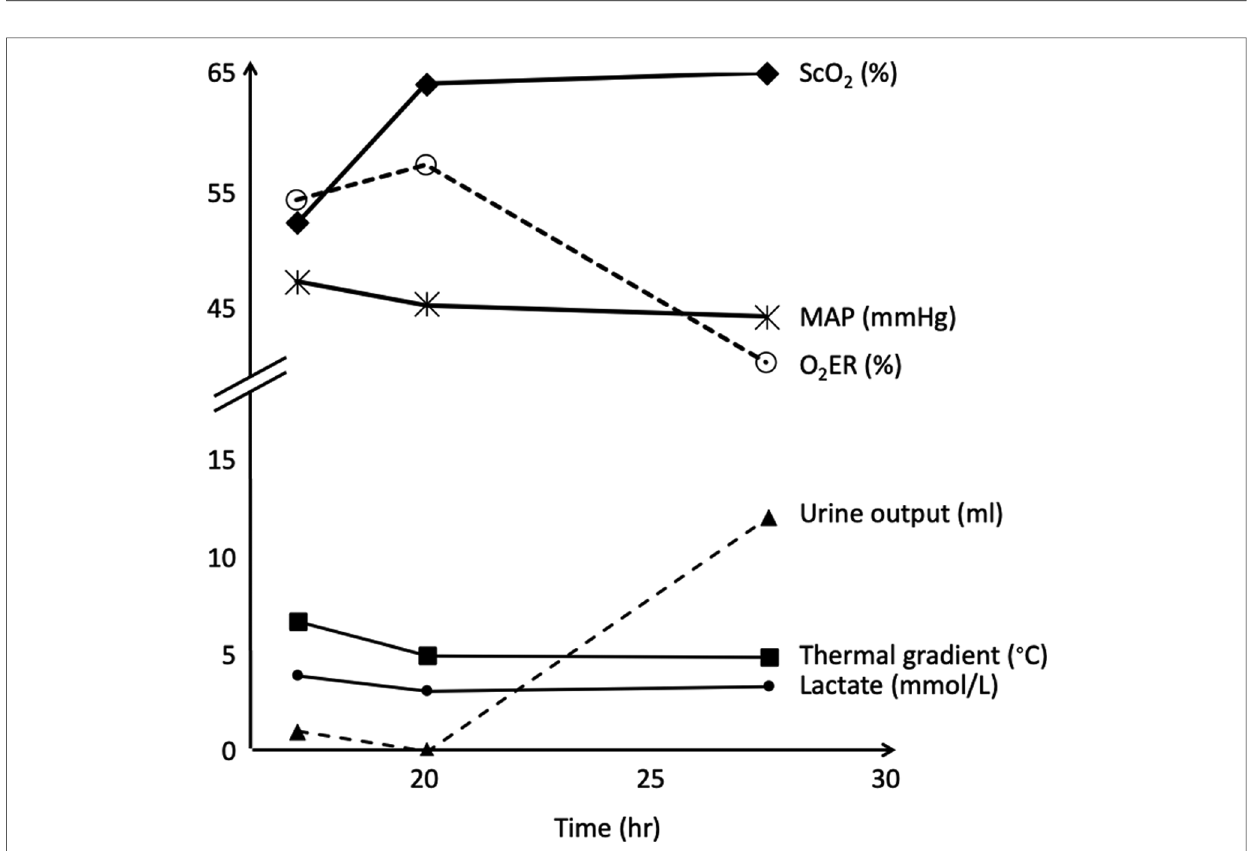
FIGURE 4 Post- operative follow-up of the thermal gradient and other hemodynamic variables over time for a neonate with a pulmonary atresia and a ventricular septal defect. Thermal gradient showed a parallel evolution to that of the cerebral blood oxygen saturation and blood lactate levels. ScO 2 , cerebral blood oxygen saturation measured by near infrared spectroscopy; MAP, mean arterial pressure; O 2 ER, oxygen extraction